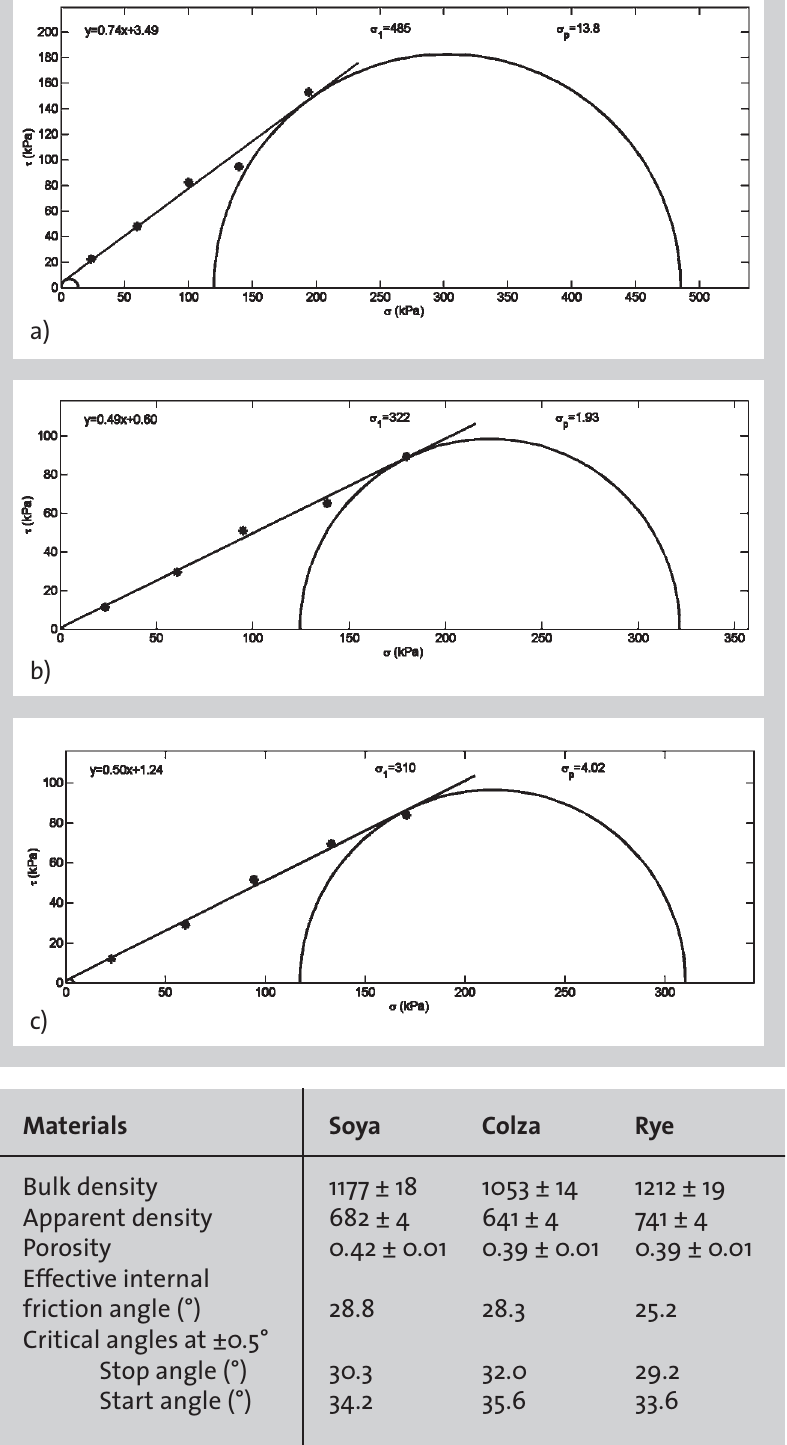
Figure 4: Typical Effective Yield Locus of the granular materials tested with consolidation stress s = 128 kPa: c a) soya, b) colza, and c) rye. Table 2: Characteristics of the granu- lar materials